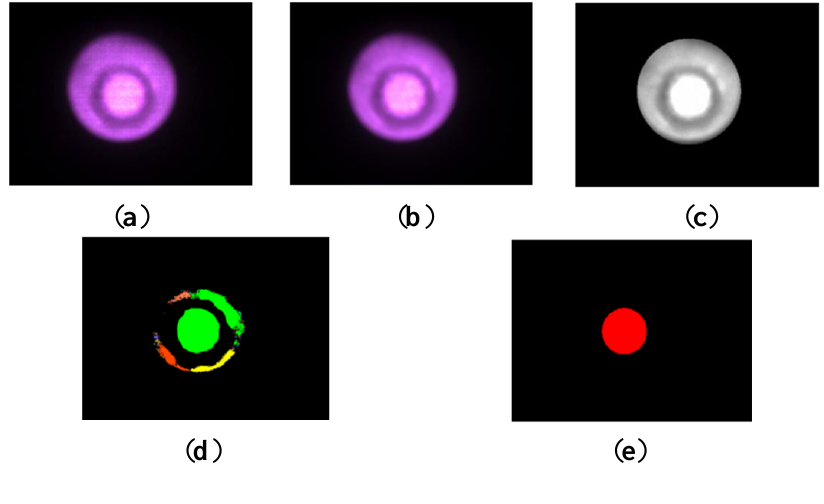
Figure 7. ( a ) Original image ( b ) Smoothing and edge enhancement ( c ) Grayscale image (d) Binarizing and selecting area (e) Obtained circular area of